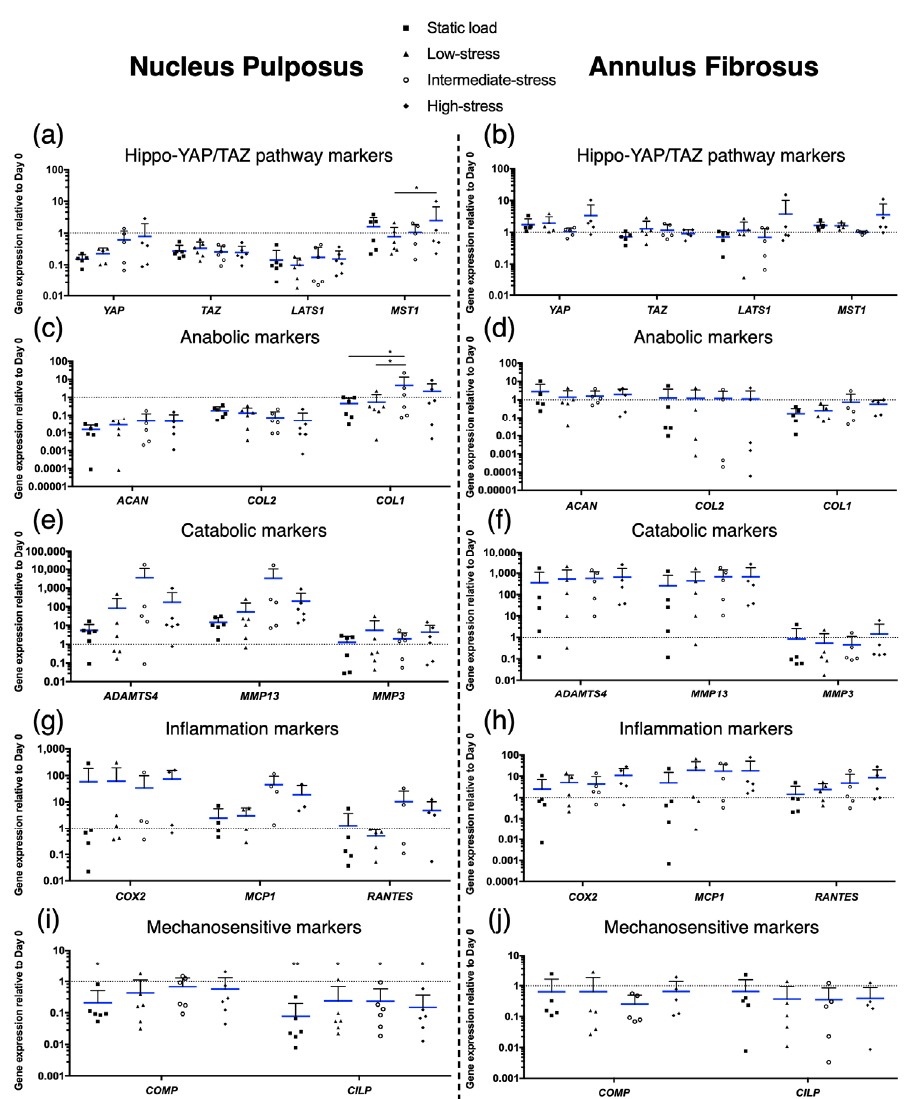
Figure 3. Relative gene expression of ( a , b ) key genes of the Hippo-YAP/TAZ pathway, including YAP , TAZ , LATS1, and MST1 ; ( c , d ) anabolic IVD-related extracellular matrix (ECM) genes, including ACAN , COL2, and COL1 ; ( e , f ) catabolic genes, including ADAMTS4 , MMP13, and MMP3 ; ( g , h ) inflammatory genes, including COX2 , MCP1, and RANTES ; and ( i , j ) genes sensitive to mechanic stimuli, including COMP and CILP , in the nucleus pulposus (NP) and in the annulus fibrosus (AF). Mean ± SD, N = 3–6, p -value: * <0.05, **